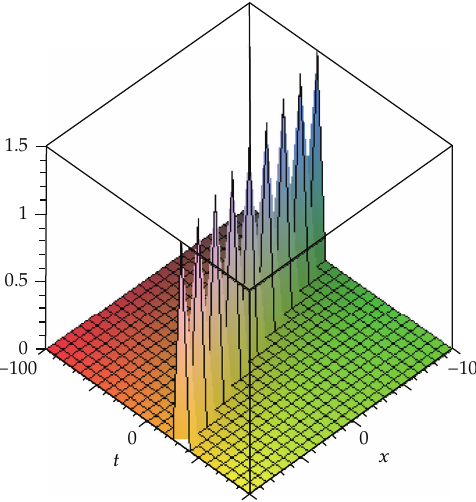
Figure 5: Solitons solution for y (cid:8) 0 and z (cid:8)